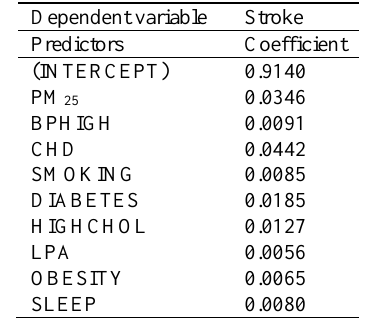
Table 4. Ridge regression results (logλ= 1.8, λ = 6.05,